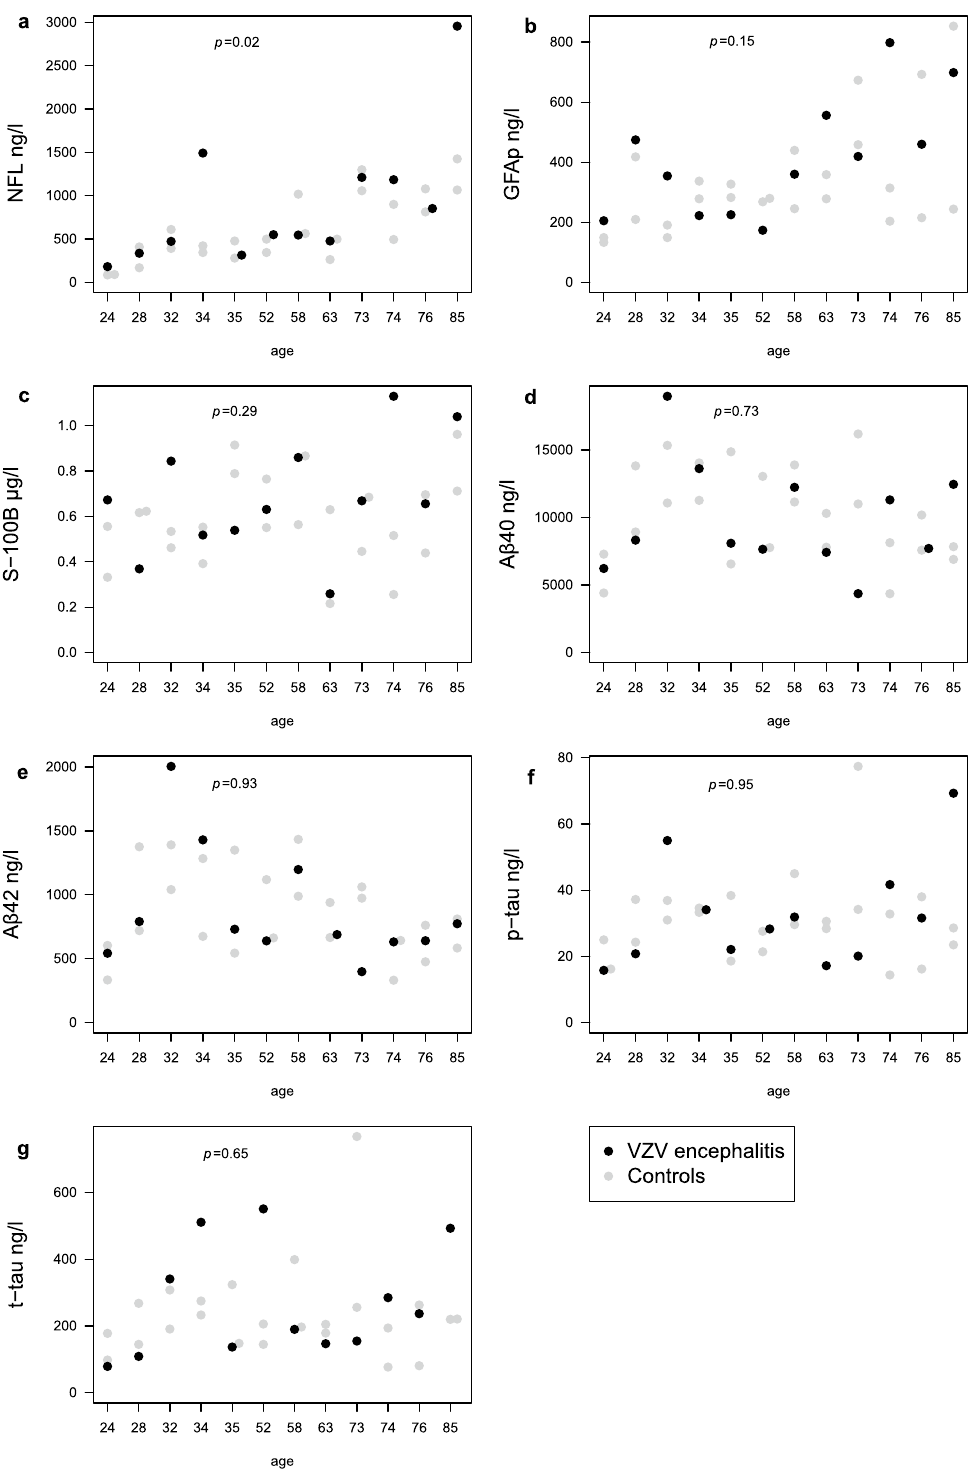
Figure 1. ( a–e ) Concentrations of cerebrospinal fluid biomarkers in patients with encephalitis caused by reactivated varicella-zoster virus (n = 12), 41 months (range: 19–85) after acute disease, and their controls (n = 24) ( a ) neurofilament light chain (NFL), ( b ) glial fibrillary acidic protein (GFAP), ( c ) S-100B, ( d ) amyloid-β 40 (Aβ40), ( e ) amyloid-β 42 (Aβ42), f) phosphorylated tau (p-tau), g) total tau